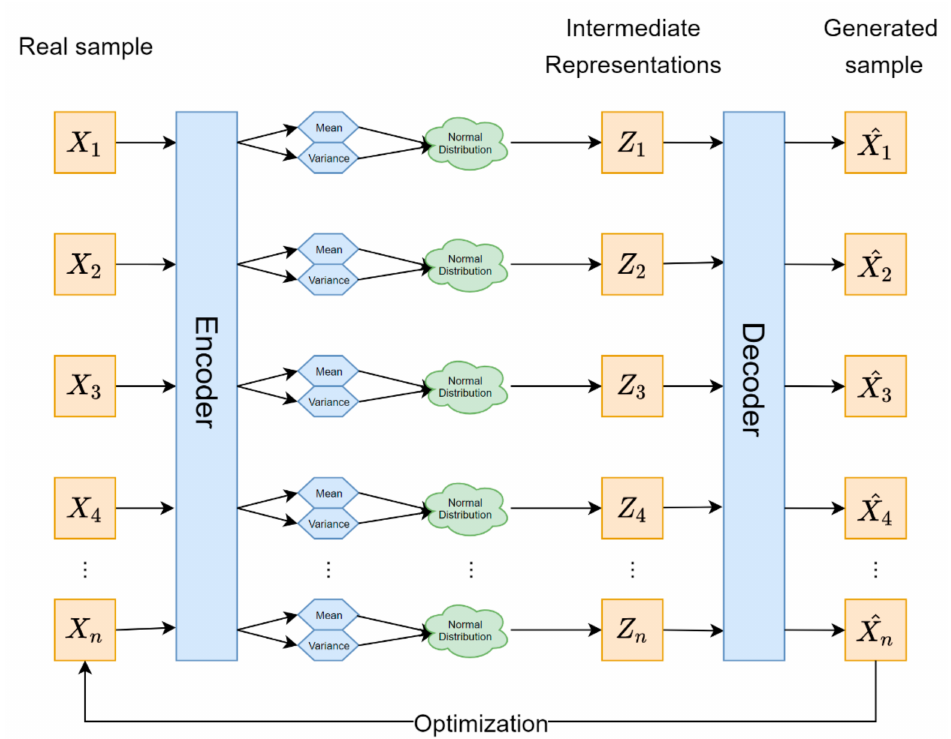
Figure 5. Schematic diagram of the basic principle of a variational auto-encoder. X is trained by two encoders separately to obtain the mean and variance, which are kept close to the normal distribution by an additional loss function to obtain a probability distribution Z conforming to X . Z is reduced to ˆ X , similar to X by a decoder and continuously optimized by reconstructing the error loss